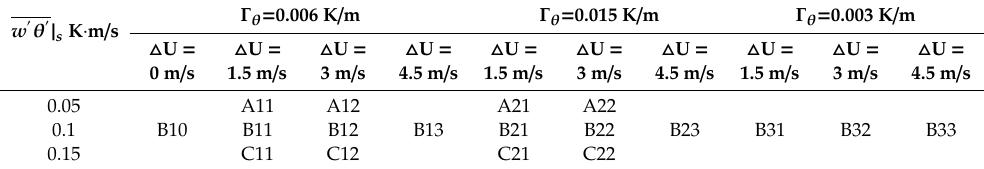
Table 1. Details of the large-eddy simulation (LES) cases with di ff erent combinations of ∆ U , Γ θ and (cid:12) (cid:12) w (cid:48) θ (cid:48) . The first letter in the case name represents the surface buoyancy flux (A: 0.05 K · m / s, B: 0.10 K · m / s, (cid:12) s and C: 0.15 K · m / s,), the first number after the letter denotes the extent of the potential temperature gradient (1: 0.006 K / m, 2: 0.015 K / m, and 3: 0.003 K / m), and the second number after the letter represents the velocity di ff erence across the entrainment zone (0: 0 m / s, 1: 1.5 m / s, 2: 3.0 m / s, and 3: 4.5 m / s).